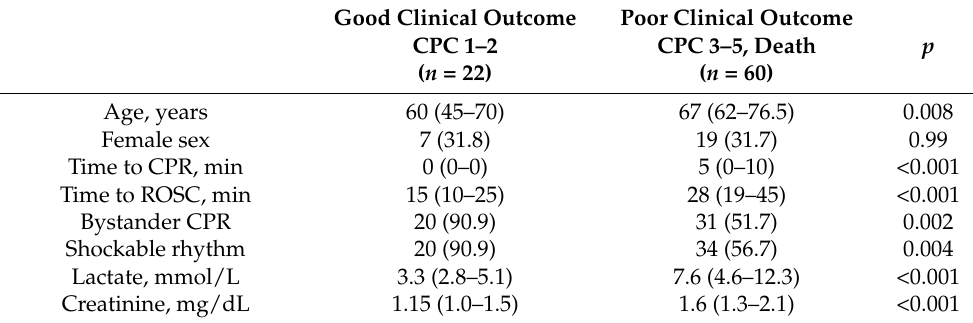
Table 1. Basic demographic and clinical characteristics for the good and bad clinical outcome patient groups admitted after out-of-hospital cardiac